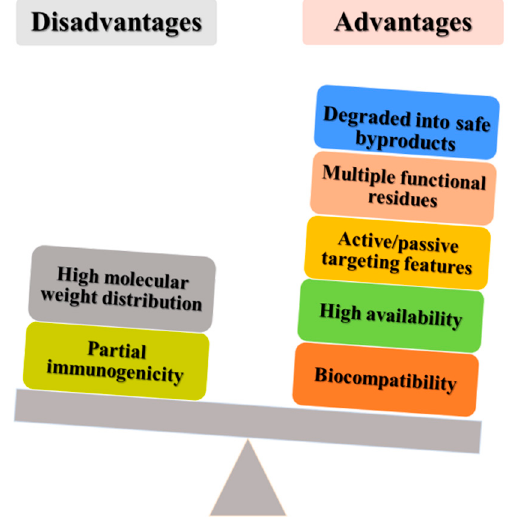
Figure 1. Main advantages and disadvantages of using plant proteins in drug delivery.